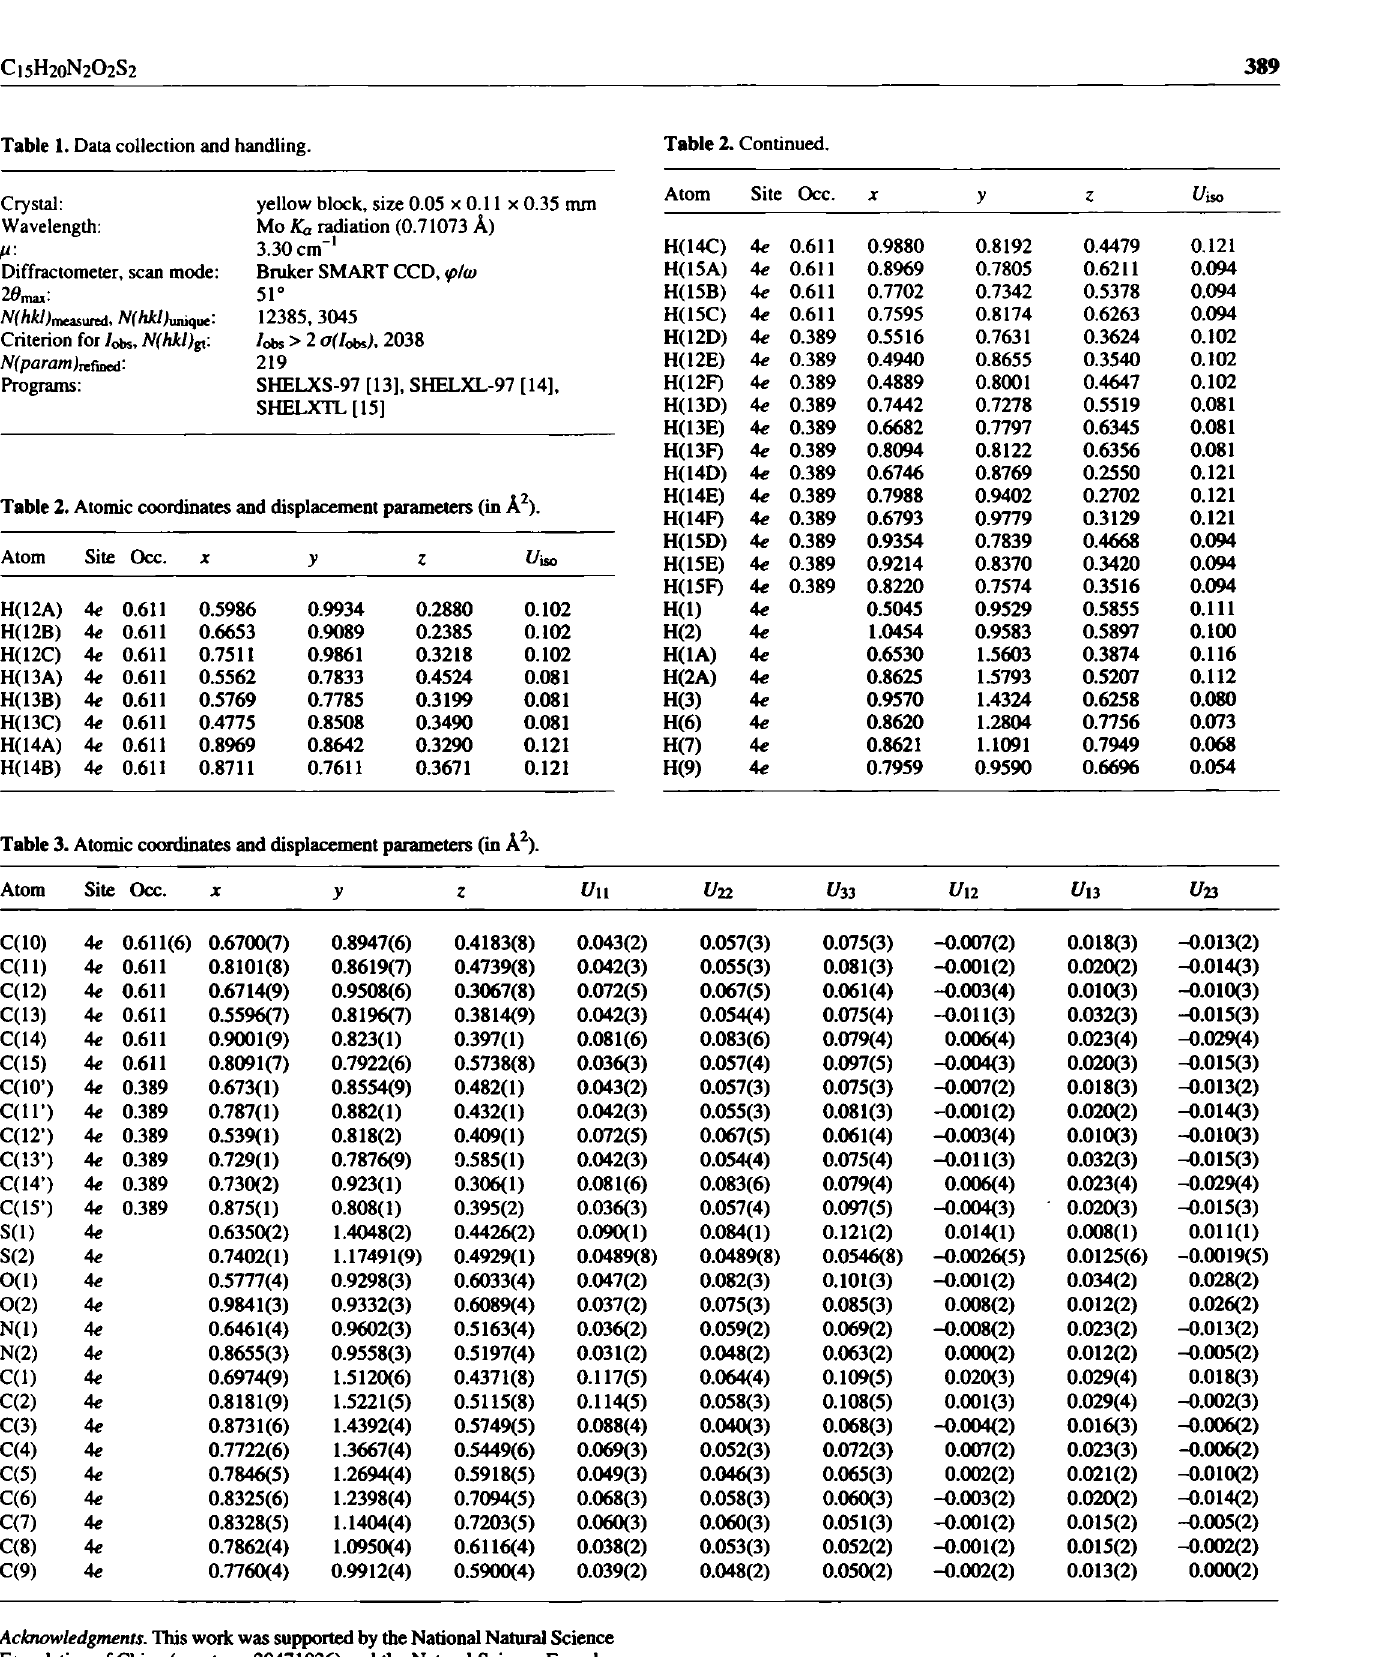
Table 1. Data collection and handling.